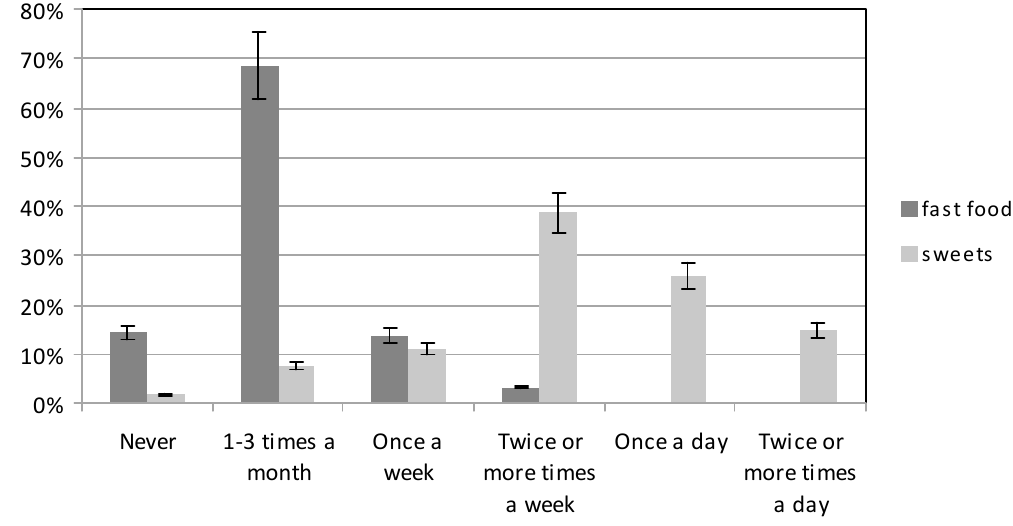
Figure 8. The consumption of fast food and sweets by participants.